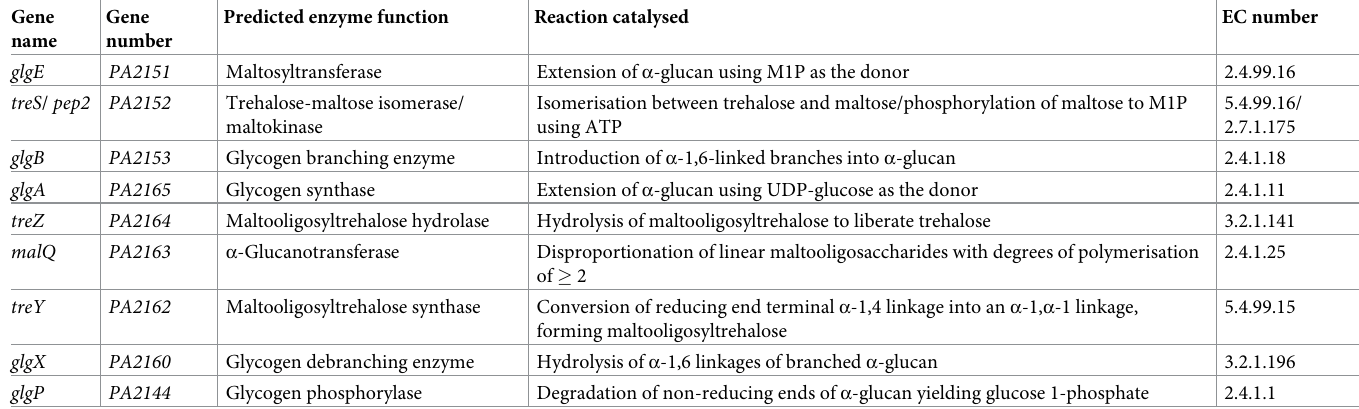
Table 1. Predicted functions of the trehalose/ α -glucan metabolic genes in P . aeruginosa PAO1 that were tested in this